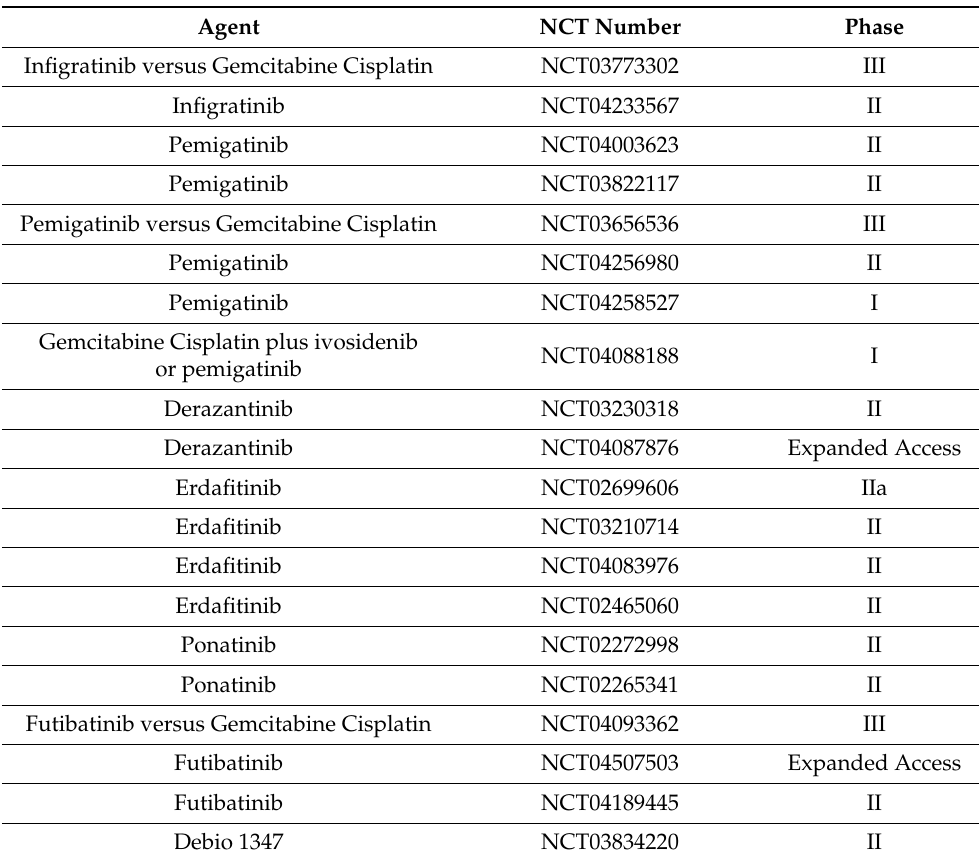
Table 1. Ongoing clinical trials evaluating FGFR inhibitors in advanced cholangiocarcinoma, accord- ing to ClinicalTrials.gov (accessed on 10 January